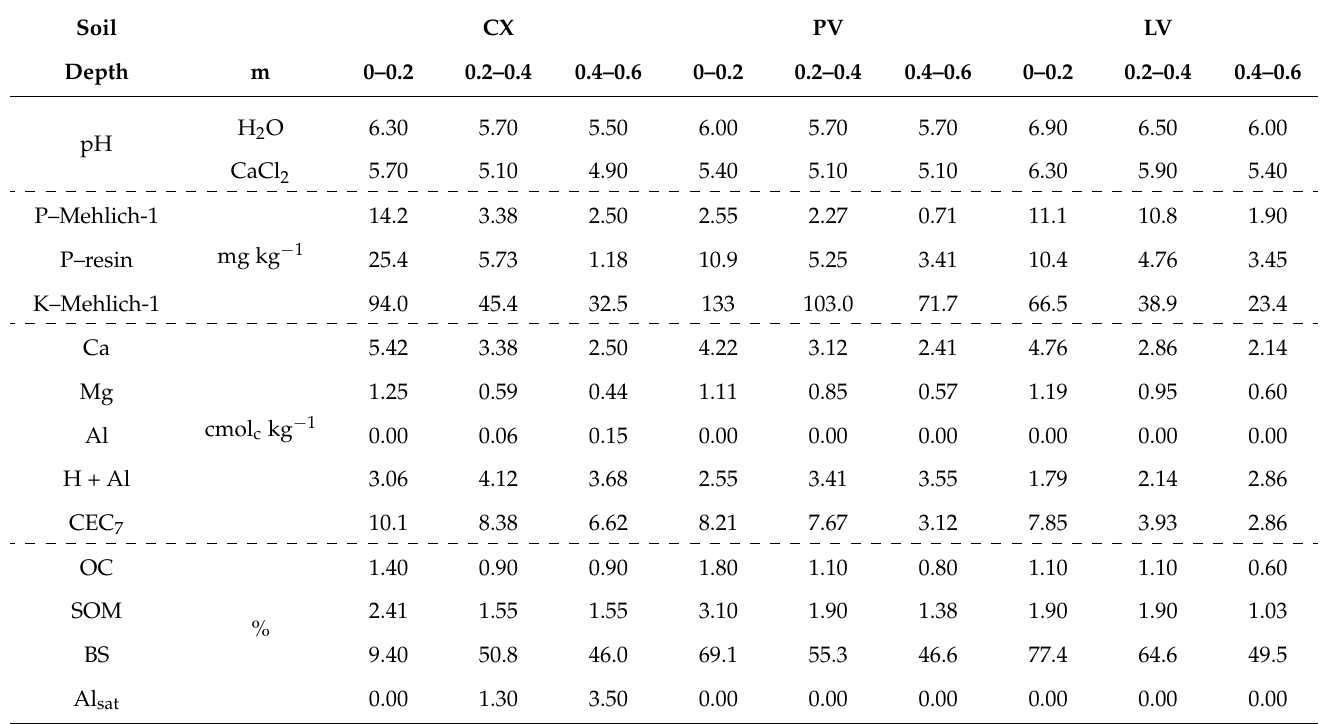
Table 3. Chemical characterization of the soils of the experimental